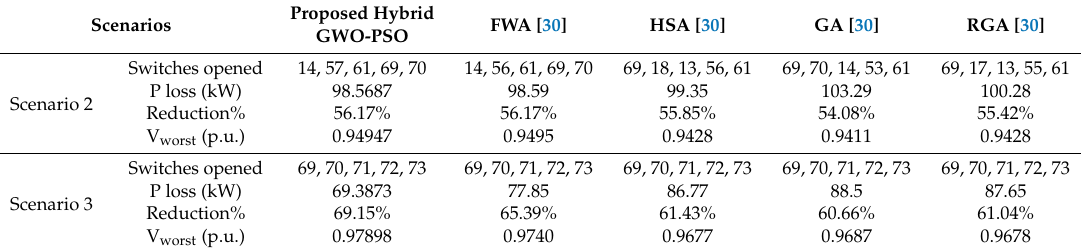
Figure 12. Conversion curve of the 69-bus system using three different methods for scenario 8. Table 7. Comparison of methods performance for the 69-bus system.